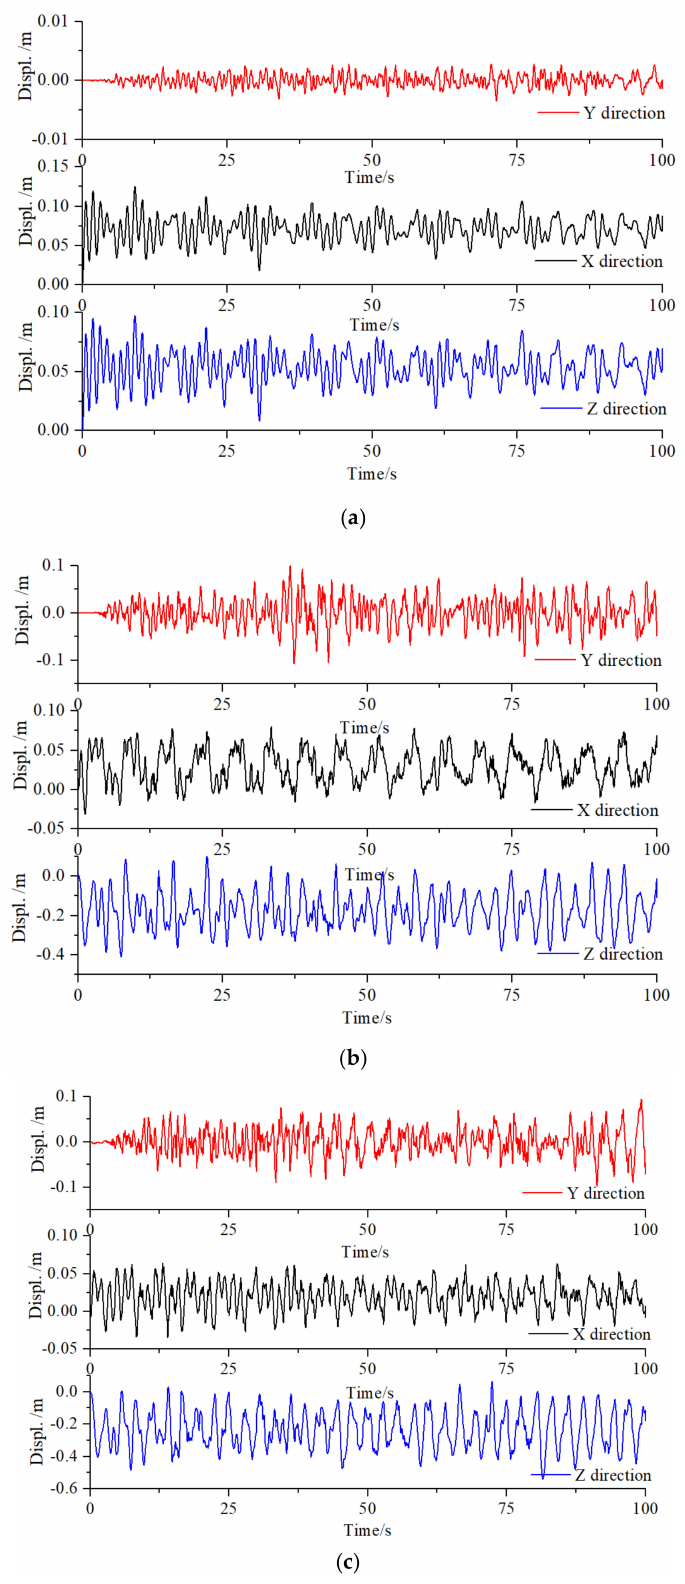
Figure 8. Displacement time history curves of typical bars. ( a ) Displacement time history curves of Upper-Pressure Ring (UPR) 20; ( b ) Displacement time history curves of Upper-Pressure Ring (URC) 21; ( c ) Displacement time history curves of Lower Radial Cables (LRC)